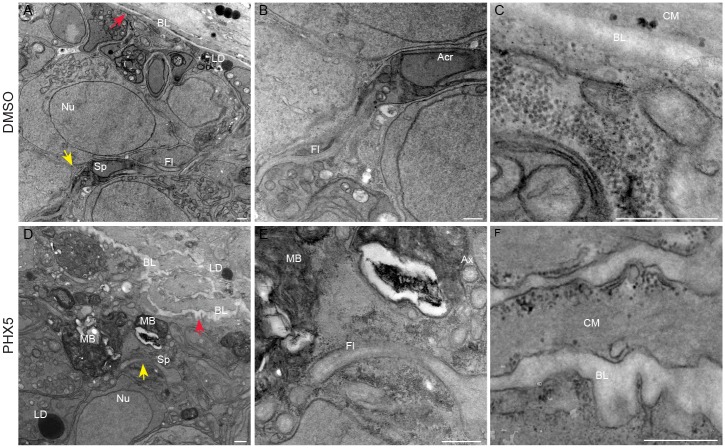
Testis degeneration in adult male worms treated with PHX—Transmission electron microscopy.Representative images of adult male testis. S. mansoni worm couples were treated with DMSO (A-C) or PHX (5 μM) (D-F) for 48 hours as indicated. Membranous bodies (MB), basal lamina (BL), flagellum (Fl), spermatozoa (Sp), acrosome (Acr), lipid droplets (LD), nucleus (Nu), circular muscle (CM), axonema (Ax). Yellow and red arrows in low magnification panels (A, D) point out high magnification fields of view of B, C and E, F respectively. Scale bar = 500 nm.